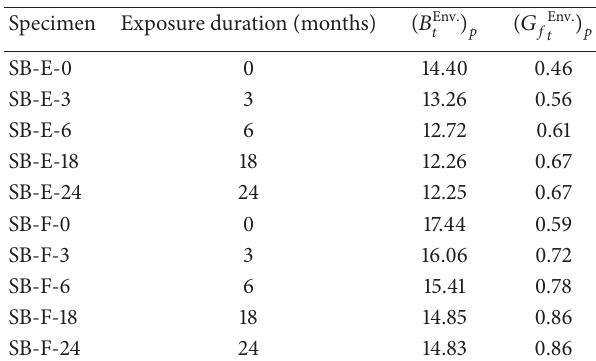
Figure 8: Relative change in bond strength and fracture energy after immersion.